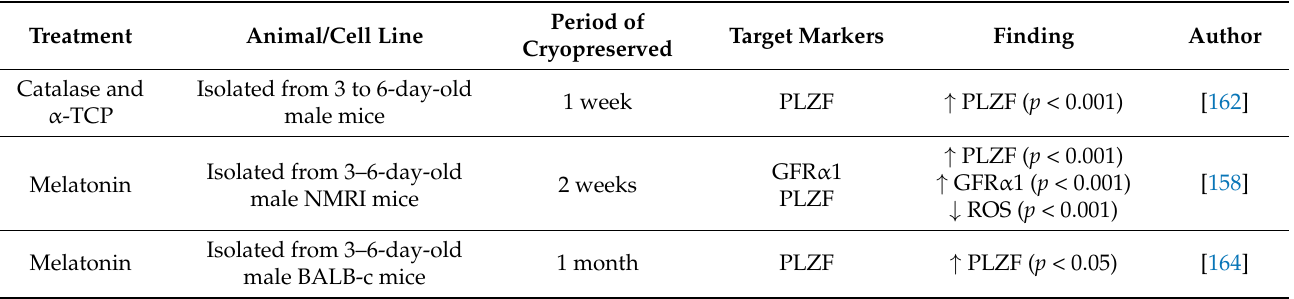
Table 1. Antioxidant function in cryopreservation of SSCs and expression of PLZF and GFR α 1 in assessing the functionality of